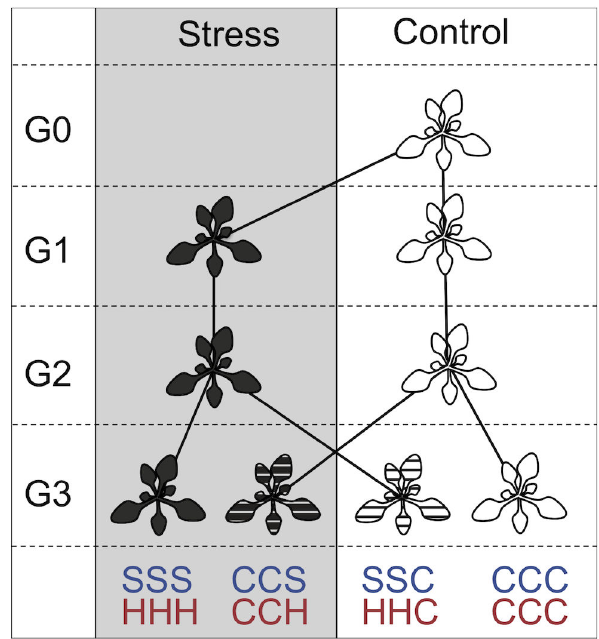
Figure 1. Setup of the experiment. G0 = generation 0, G1 = generation 1 etc. In blue, SSS refers to three generations of salt treatment, CSS indicates that the first generation was grown under control conditions followed by two generations in stress treatment etc., while in red HHH refers to three generations of heat treatment, etc. In G0, only one individual was grown, whereas in G1 to G3, 25 individuals per treatment were grown. Plants were propagated by single seed descent, and in case of mortality, missing plants were restocked by duplicating other lines of the same